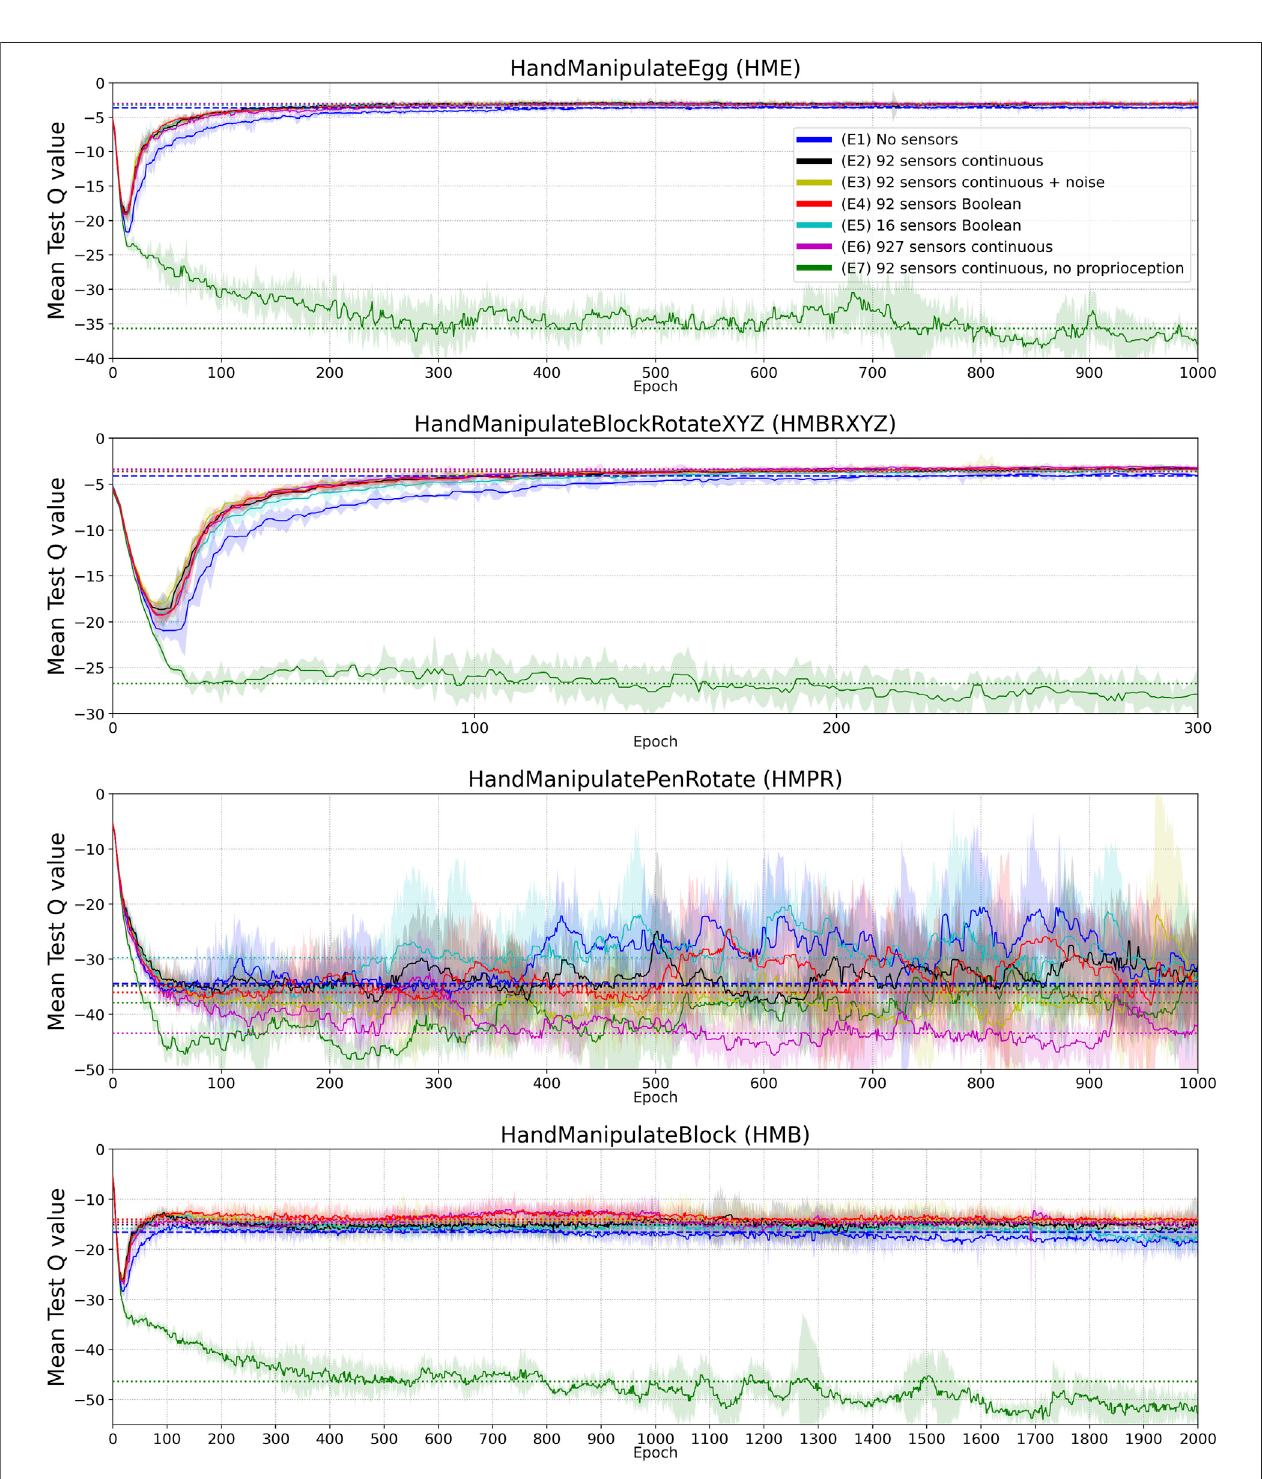
FIGURE A2 | Full version of Figure 5 .